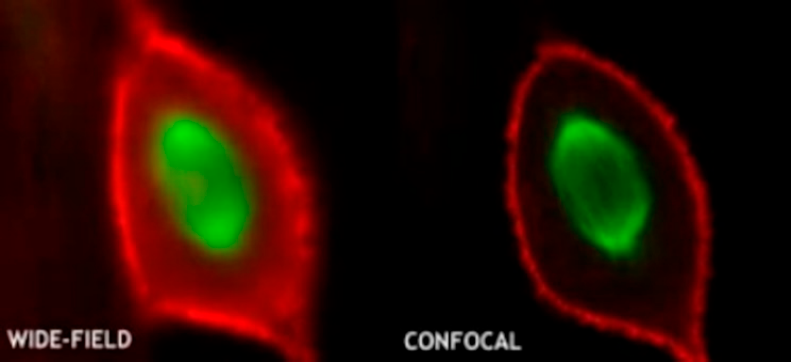
Figure 4. Principle scheme of confocal laser scanning microscopy.